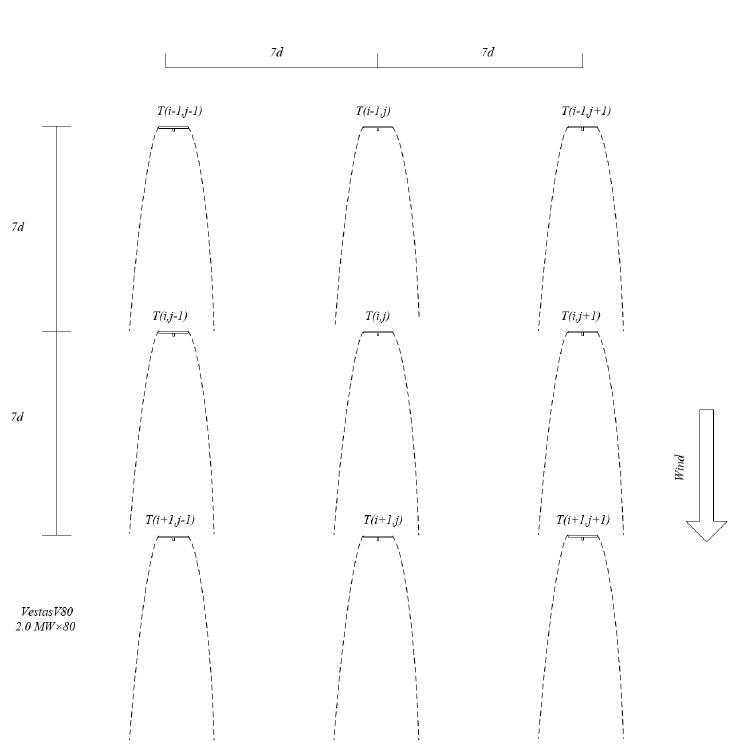
Figure 3. Neighboring wind turbines in the far wake of the Horns Rev OWF, Denmark.